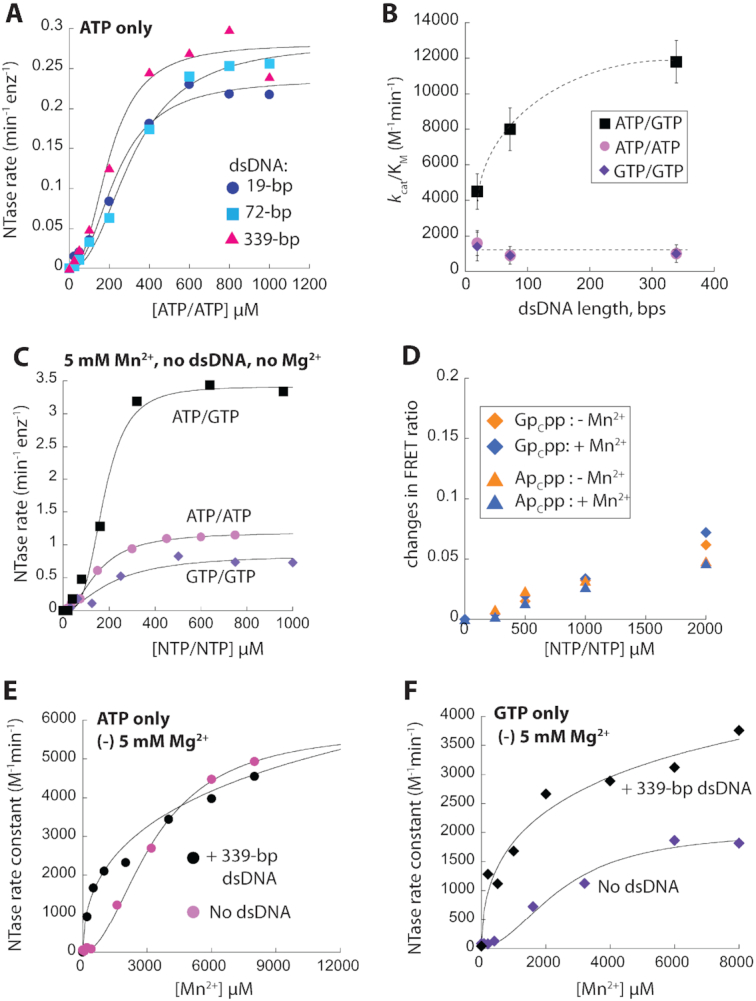
The positive coupling between Mn2+ and dsDNA binding requires cognate ATP/GTP. (A) The NTase activity of 100 nM cGASFL with increasing [ATP] and saturating amounts of various dsDNA lengths (5 mM MgCl2 and no MnCl2). (B) A plot of kcat/KM for ATP/GTP, ATP/ATP, and GTP/GTP versus saturating amounts of different dsDNA lengths (5 mM MgCl2 and no MnCl2). Dotted lines trace the change in activity over increasing dsDNA lengths. n ≥ 3, ± SD. (C) The NTase activity of 100 nM cGASFL with increasing [NTP], 5 mM MnCl2, and without dsDNA or any MgCl2. (D) Changes in FRET ratios of 1:1 TAMRA:Cy5-labeled 20 nM cGASFL as a function of Apcpp or Gpcpp. 5 mM MgCl2 and with or without 5 mM MnCl2. (E, F) The NTase activity of 100 nM cGASFL as a function of [MnCl2] without additional Mg2+ and in the presence or absence of saturating dsDNA. 200 μM NTP/NTP.